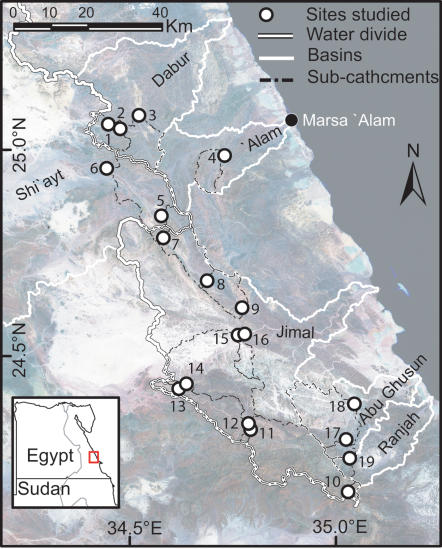
Study area. Studied sites in relation to basins, sub-catchments and east-west water divide. Each site is labelled with its ID (see Table 1). A Landsat TM image is displayed in the background.